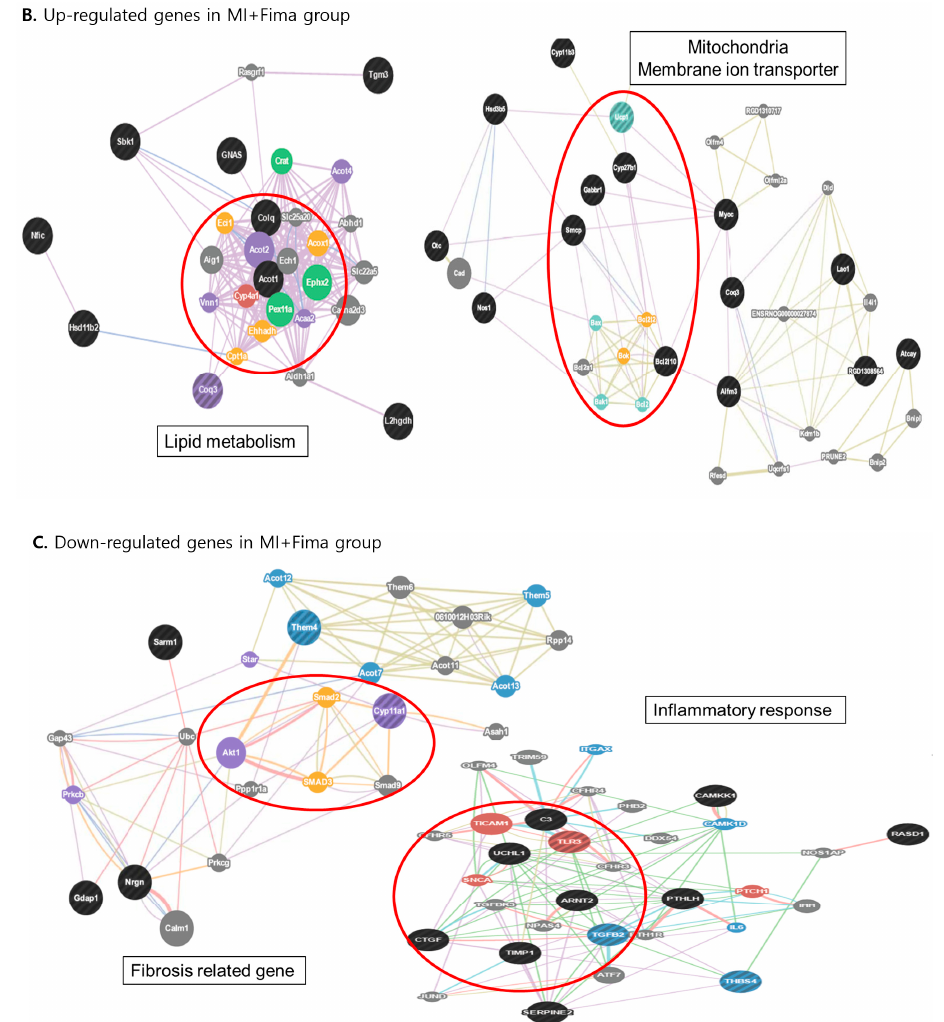
Figure 4. The transcriptional changes in the molecular pathways: ( A ) The microarray analysis in MI-only and MI + Fima group. In the MI + Fima group, 39 genes were upregulated and 19 genes were downregulated. ( B ) The clustering analysis showed the upregulation of lipid metabolism and mitochondria membrane ion transporter gene sets in the MI + Fima group. ( C ) The inflammation and fibrosis inducing genes were downregulated in the MI + Fima group.